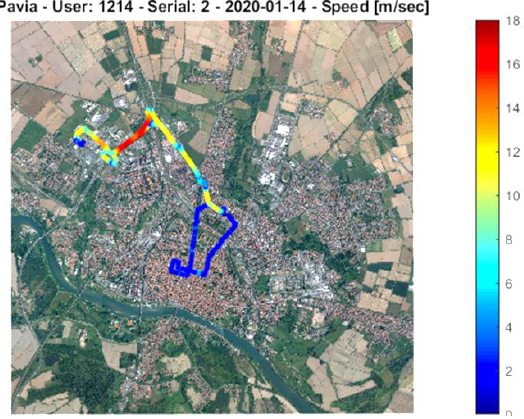
Figure 17. Velocity in m/sec for the path shown in Figure 14